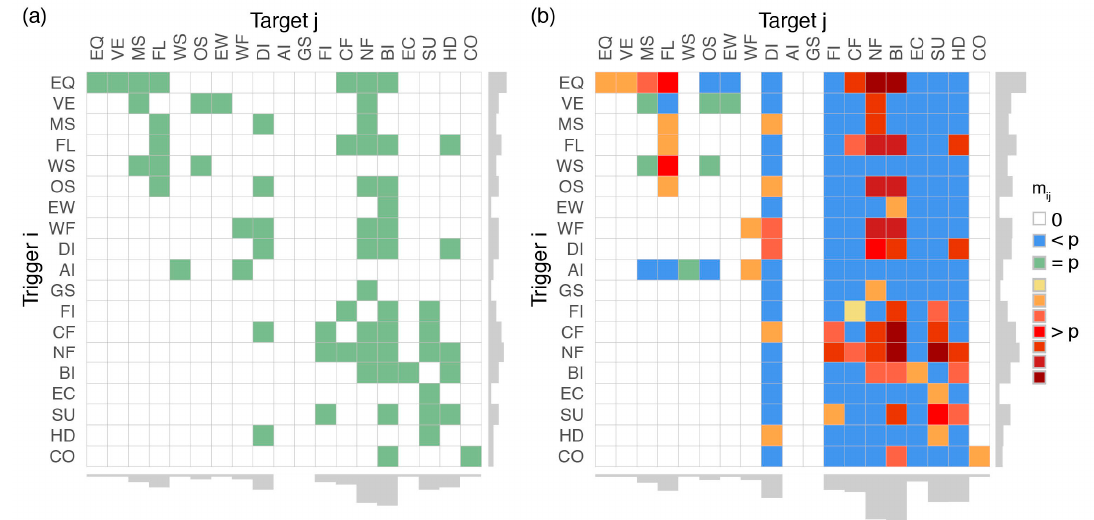
Figure 3. Topology of historical catastrophes constructed from Table 2. ( a ) Reduced adjacency matrix A ; ( b ) matching reduced interaction matrix M ( max τ = 3 ) showing both an expansion of the transient interaction set (mostly in blue) and an amplification of certain events for given initial triggers (warm colors). Warmer colors are proportional to the ad-hoc probability, here fixed to p =